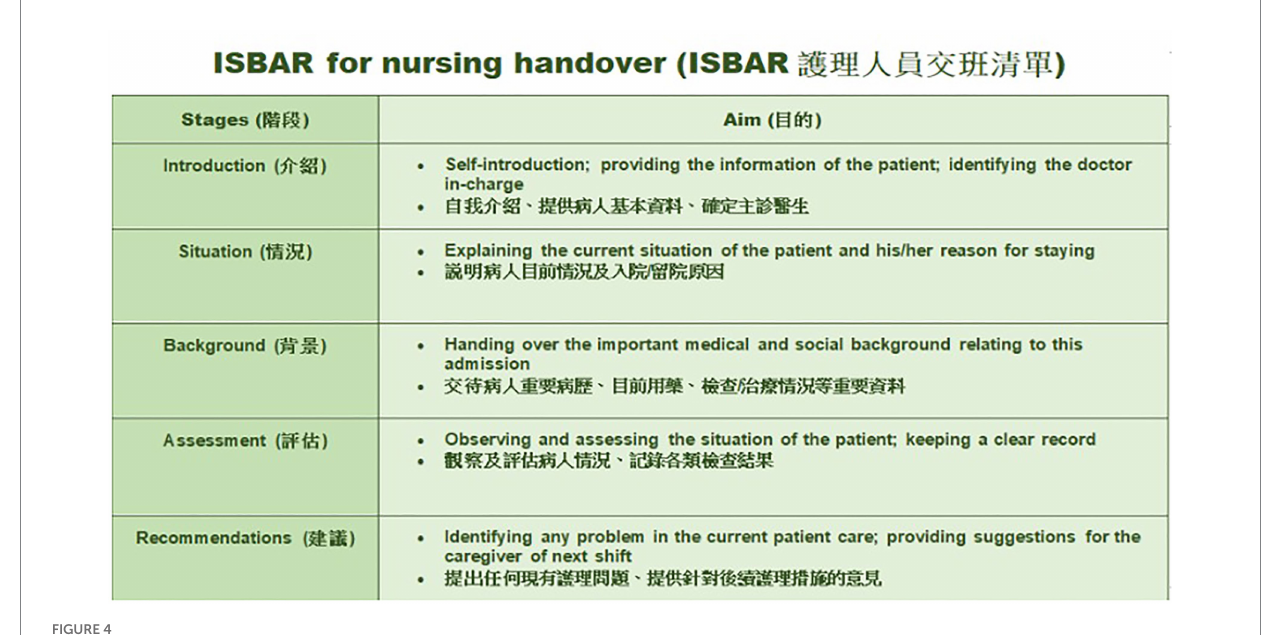
FIGURE 4 Bilingual version of the ISBAR protocol for nursing